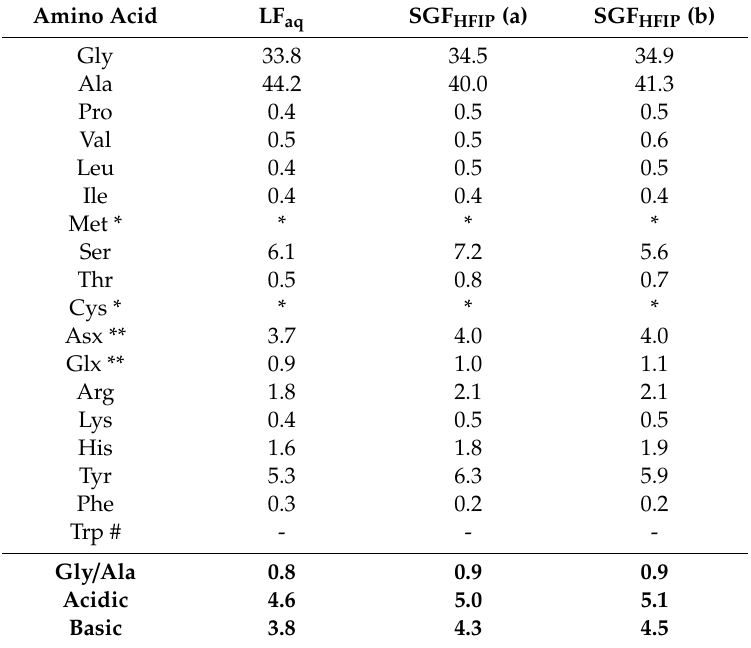
Table 1. Amino acid compositions (mol %) of films cast from aqueous liquid fibroin (LF aq ) and 1,1,1,3,3,3-hexafluoro-2-propanol (HFIP) solutions of the 40%-EtOH-treated posterior silk gland (PSG) SGF HFIP with ( a ) and without ( b ) peeling the gland epithelium. Amino Acid LF aq SGF HFIP (a) SGF HFIP (b) Gly